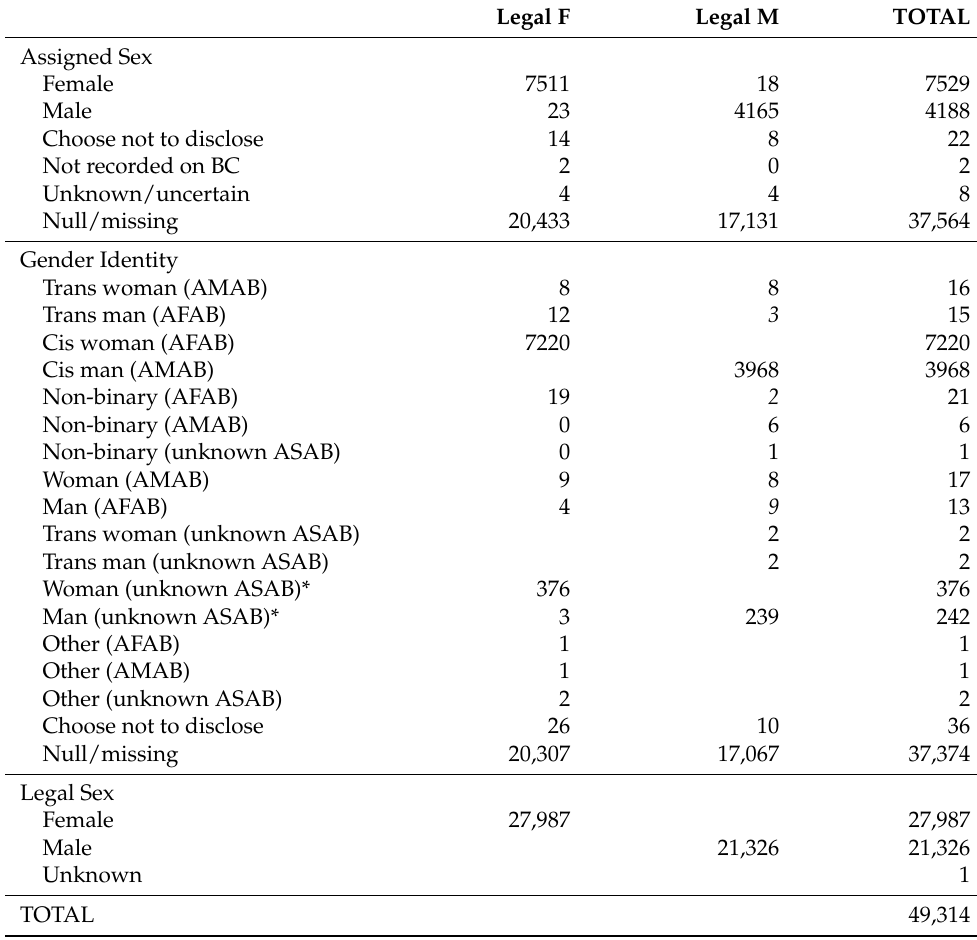
Table A1. Assigned sex at birth, gender identity, and legal sex EHR data for all Rush University Medical Center patients, 12 years and older, with unplanned hospital encounters in 2020 ( N =